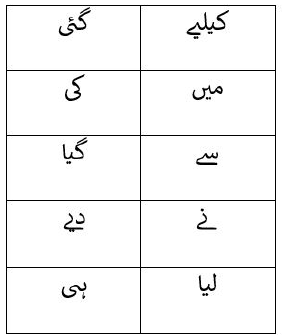
Figure 4. List of some stop words of Urdu